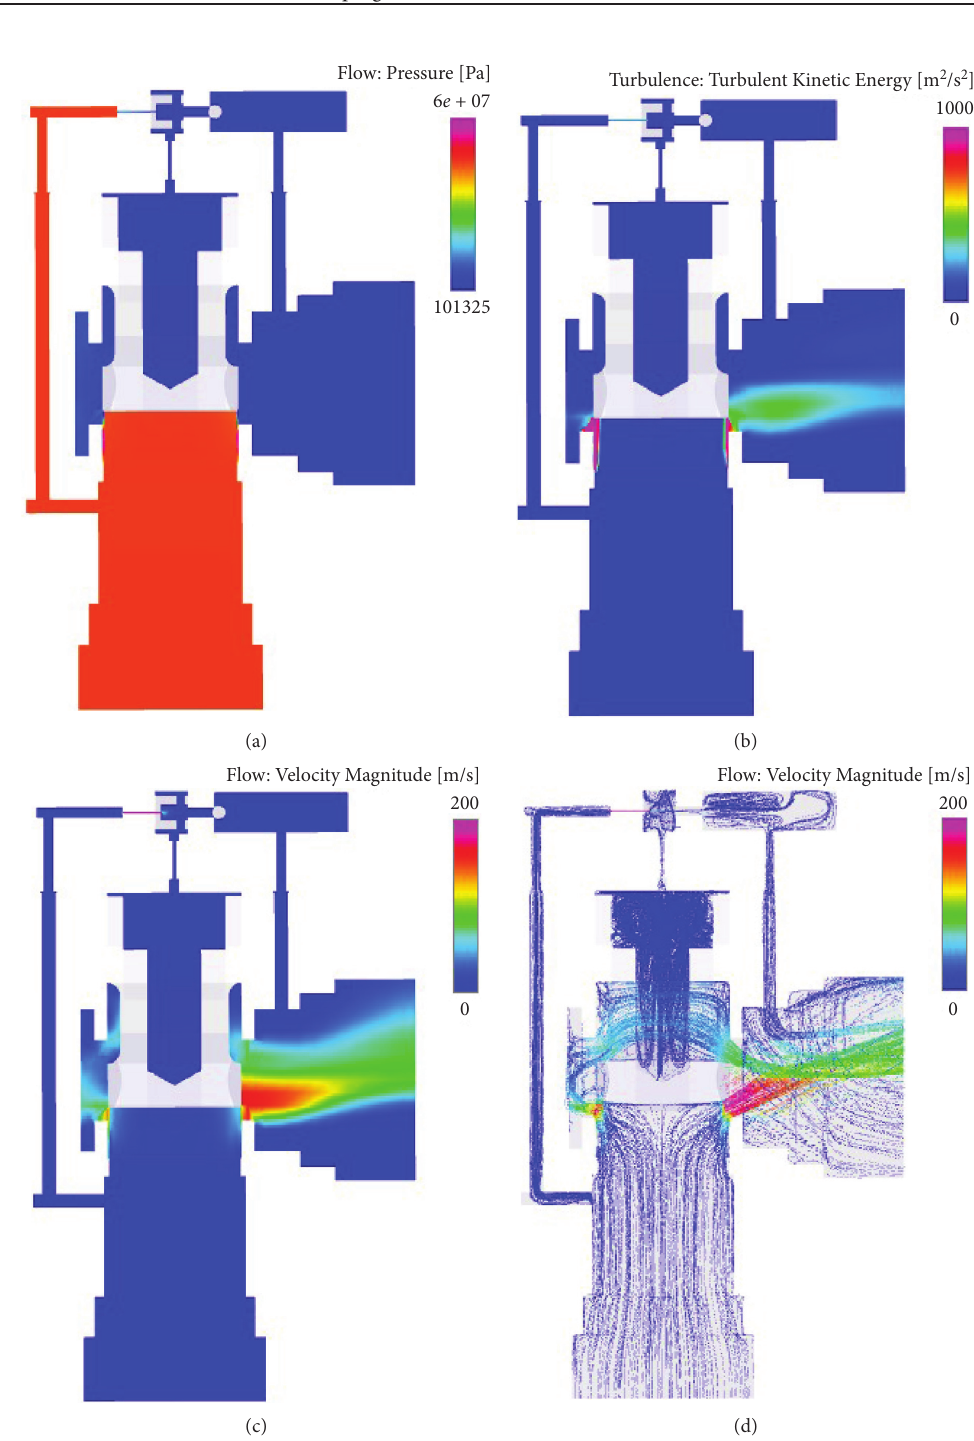
Figure 26: The cloud charts of flow field distribution. (a) Pressure distribution. (b) Turbulent kinetic energy distribution. (c) Velocity distribution. (d) Velocity streamline